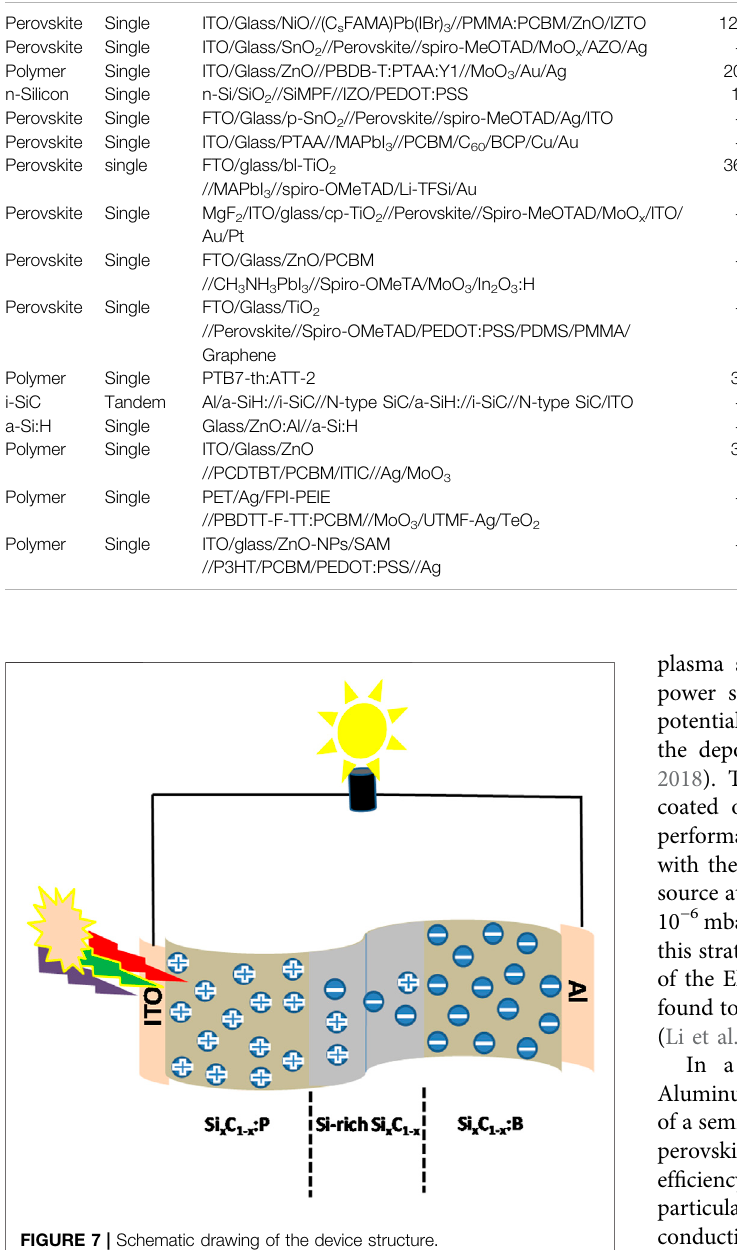
FIGURE 7 | Schematic drawing of the device